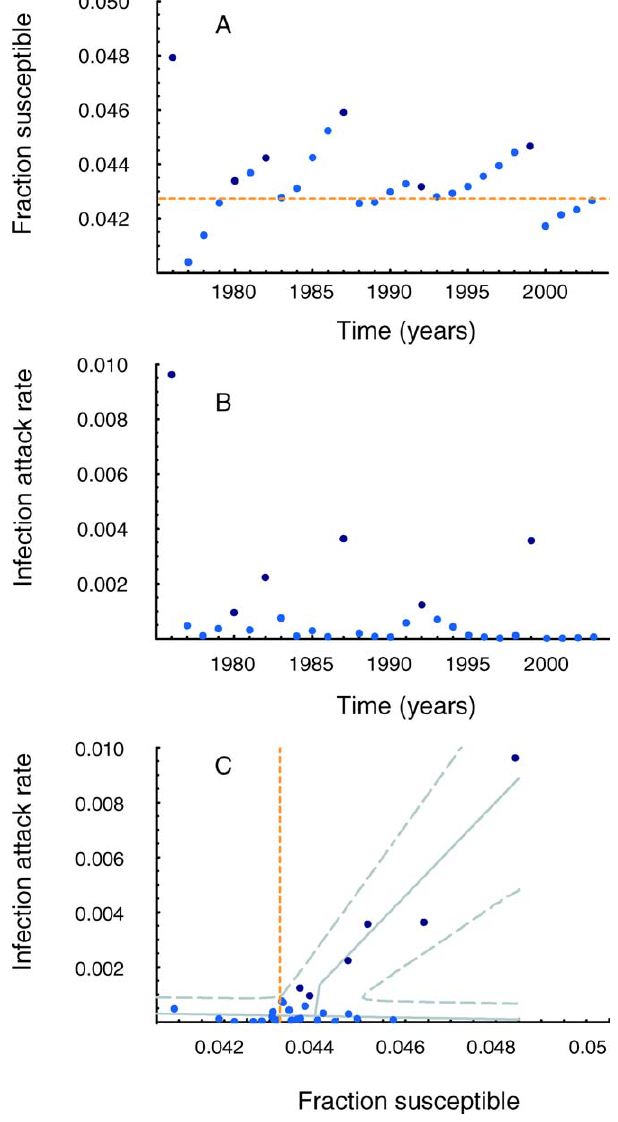
Figure 2. Observed Measles Outbreaks in the Netherlands, from 1 September 1976 to 31 August 2004 (A) The fraction of individuals susceptible to measles on 1 September of each year. (B) Infection attack rate of measles during each epidemic year from 1 September to 31 August. (C) Relation between fraction of susceptible individuals and attack rate. Dark blue markers correspond to major outbreaks; light blue markers correspond to minor outbreaks. Solid gray lines indicate the maximum likelihood values for infection attack rate; broken gray lines indicate the likelihood support region. The dotted yellow line in (A) and (C) indicates the threshold value for susceptible individuals below which solid herd immunity is achieved. DOI: